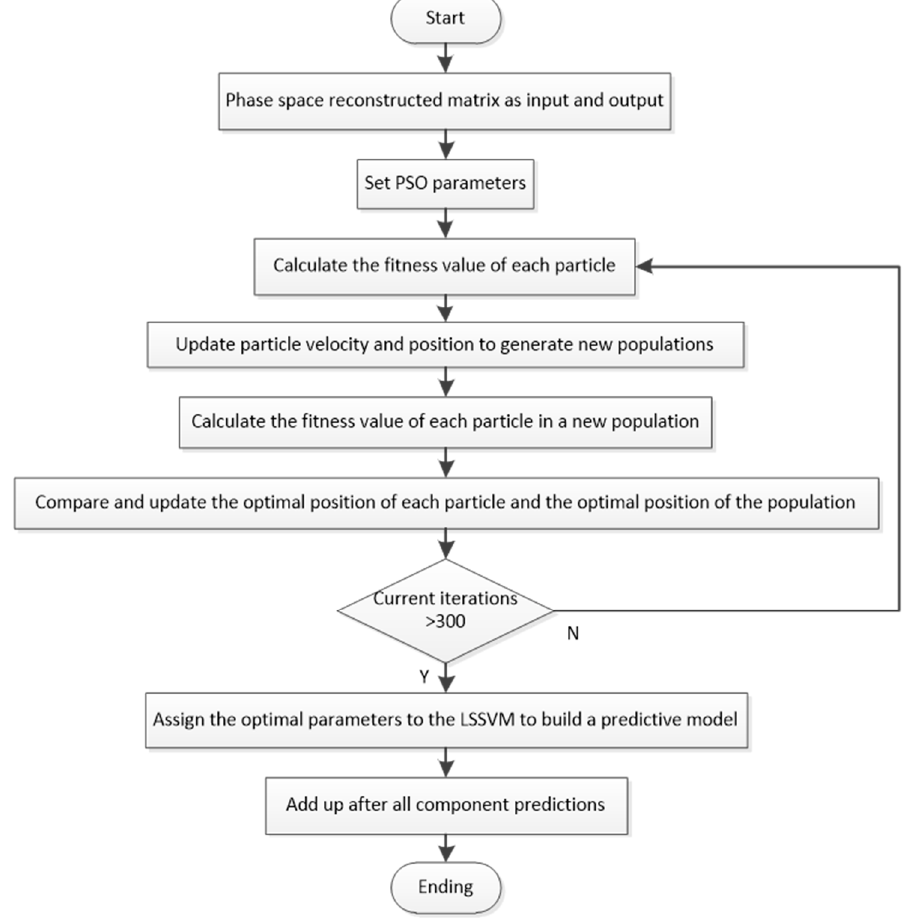
Figure 1. Flowchart of particle swarm optimization least squares support vector machine.